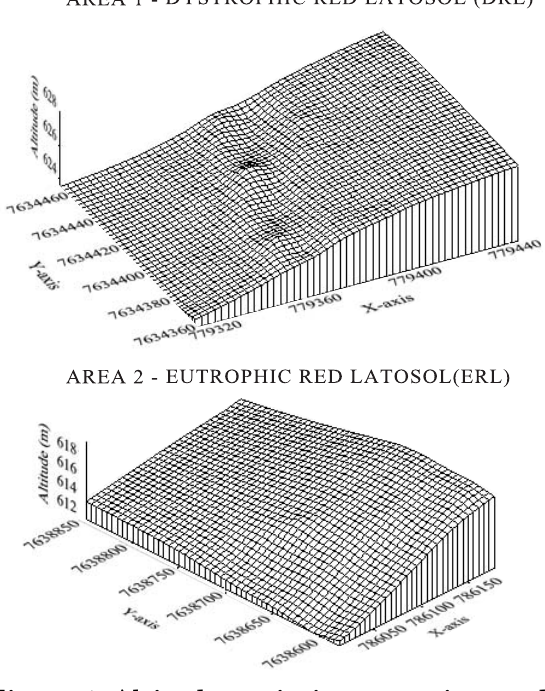
Figure 1. Altitude variation maps in x and y directions of the study